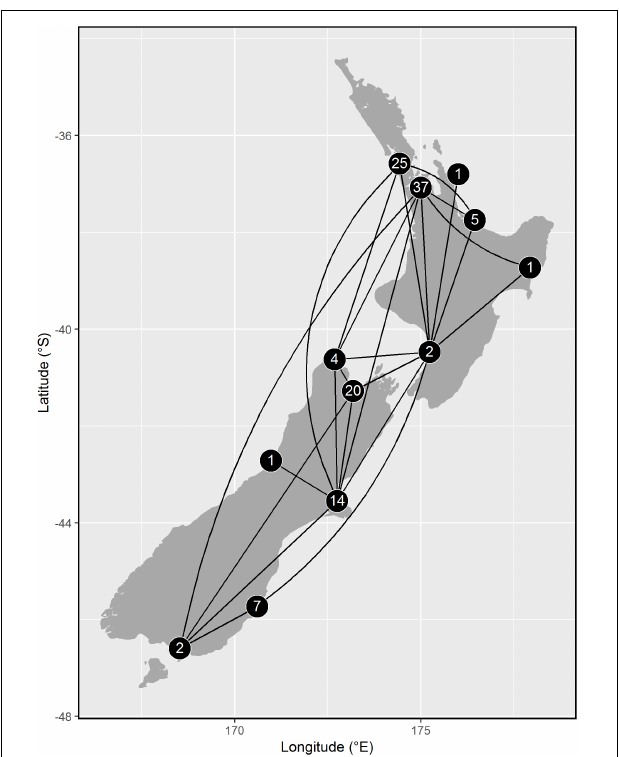
FIGURE 7 | Long-distance movements of bar-tailed godwits caught as juveniles or immatures within New Zealand on the non-breeding grounds in the pre-migration period (age < 3 years). Lines show links between regions confirmed through observations of marked birds; numbers are the number of movements to that region from another (representing 119 movements of 113 birds, out of 327